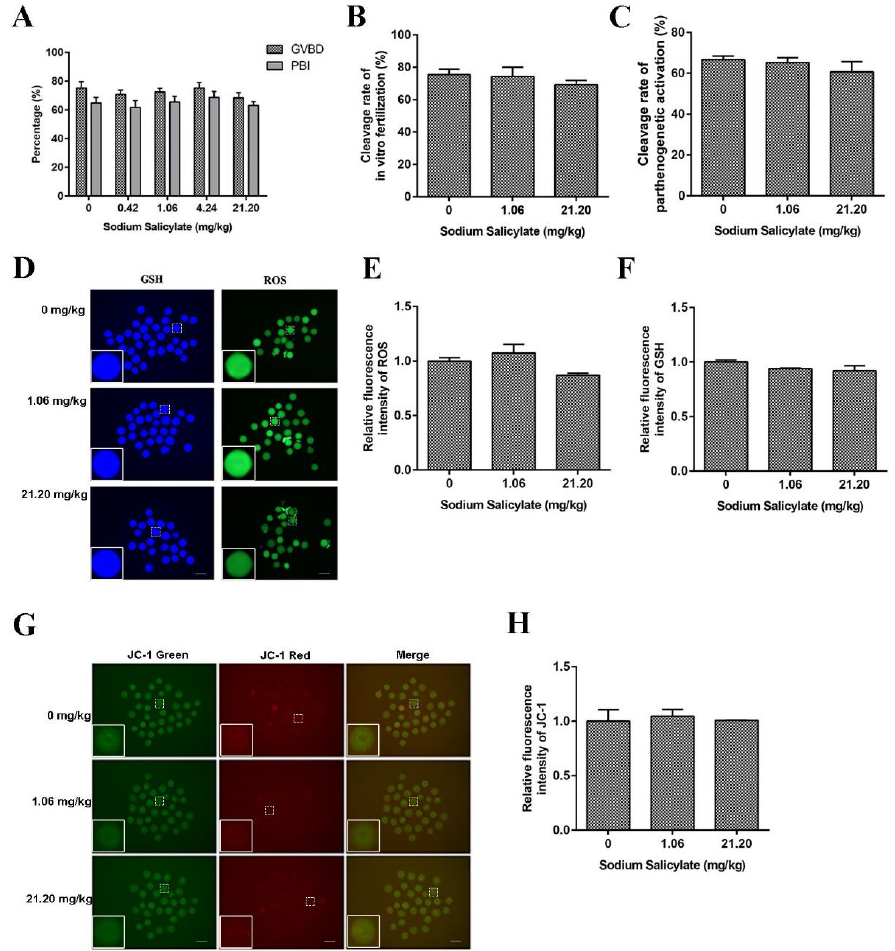
Figure 2. Effects of sodium salicylate on mouse oocytes. ( A ) Oocyte GVBD and PBI rates were not affected by sodium salicylate ( n = 6). ( B , C ) The in vitro fertilization rate ( B ) and parthenogenetic activation of oocytes ( C ) obtained from the ovaries of sodium salicylate-treated mice ( n = 6) were not affected. ( D ) GSH and ROS fluorescence in oocytes collected from ovaries in sodium salicylate-treated mice ( n = 3). ( E , F ) Fluorescence intensity of ROS ( E ) and GSH ( F ). ( G ) JC-1 fluorescence (red and green channels) was examined to detect the membrane potential of oocytes in the ovaries of mice treated with sodium salicylate ( n = 3). ( H ) Red/green ratio of JC-1 fluorescence in mouse oocytes ( n = 3). Scale bars, 100 μm.